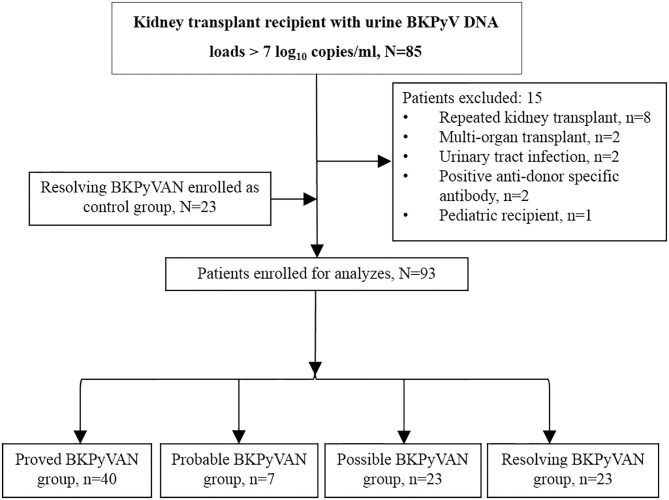
Patient inclusion flow diagram. BKPyVAN, BK polyomavirus-associated nephropathy; BKPyV, BK polyomavirus; TCMR, T cell-mediated rejection.